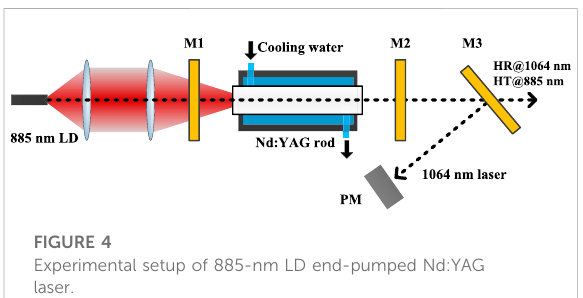
FIGURE 4 Experimental setup of 885-nm LD end-pumped Nd:YAG laser.